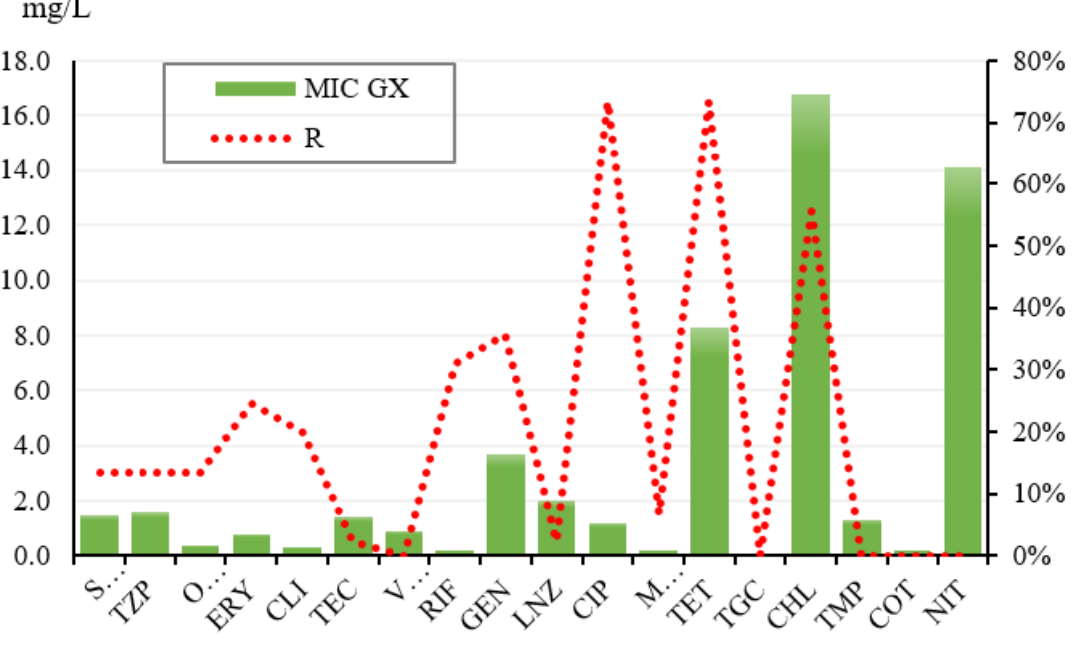
Figure 3. Overview of MIC and MIC GX in resistant Staphylococcus warneri isolates. GX MIC—Geometric average MIC—the average MIC value at which the strains are inhibited. Table 4. Phenotypic detection of various mechanisms of